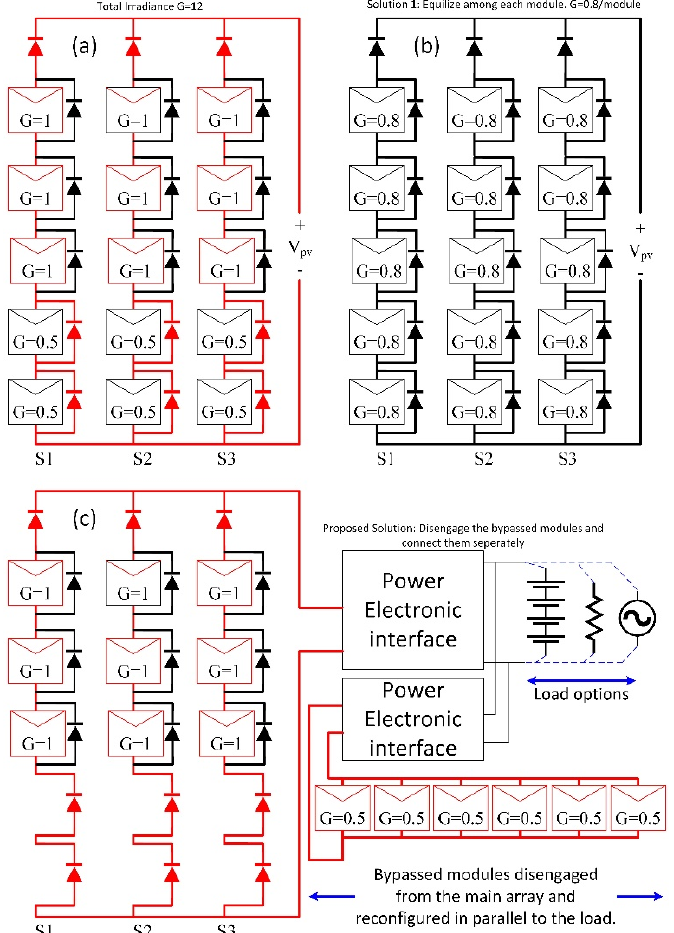
Figure 1 . The problems addressed in this paper. ( a ) An arbitrary shading condition. ( b ) Irradiance equalizer-based solution (not practically possible). ( c ) A proposed solution to reconfigure the bypassed modules separate from the main array.